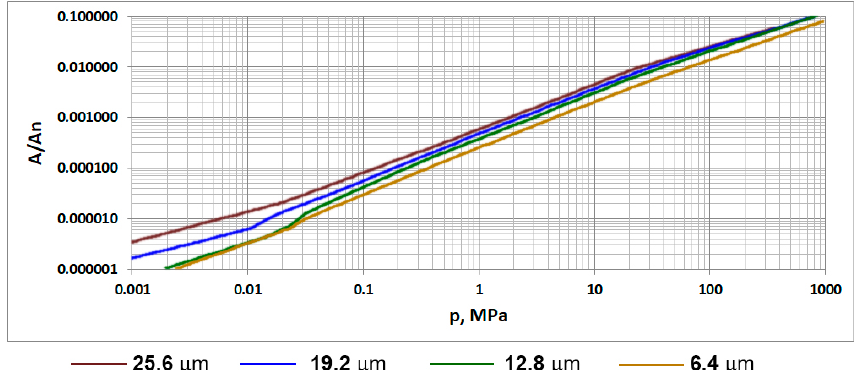
Figure 18. The dependence between the contact pressure and the contact area fraction for various sampling intervals, adapted from [172].